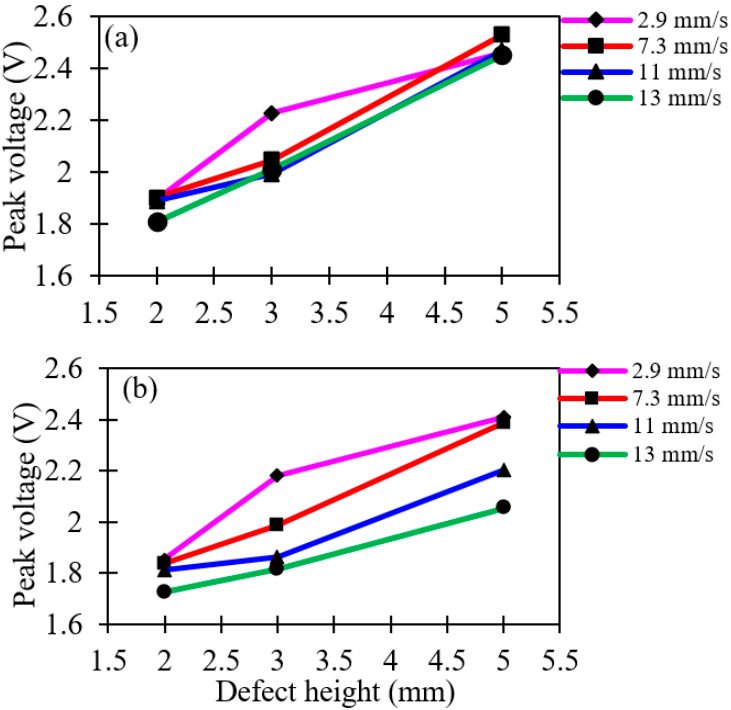
Figure 12. Peak voltage corresponding to the height of deposit corrosion defects for different lift-offs ff erent inspection speeds; ( a ) 20 mm and, ( b ) 30 at different inspection speeds; ( a ) 20 mm and, ( b ) 30 mm. di